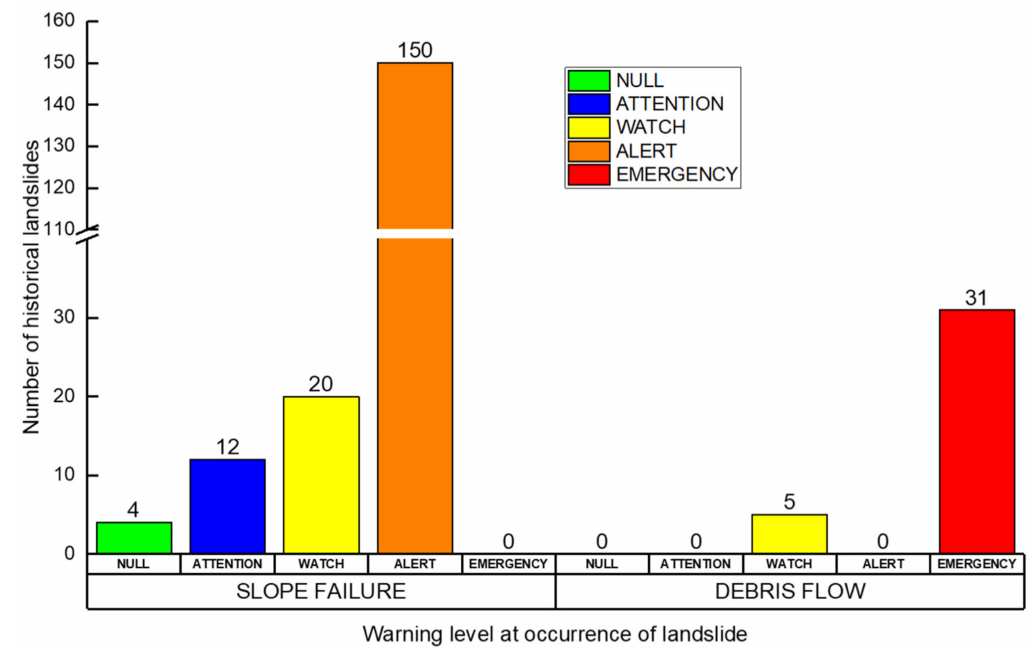
Figure 9. Prediction results of historical landslide data based on the simulation of landslide early warning system applying the sequential evaluation method for the period of